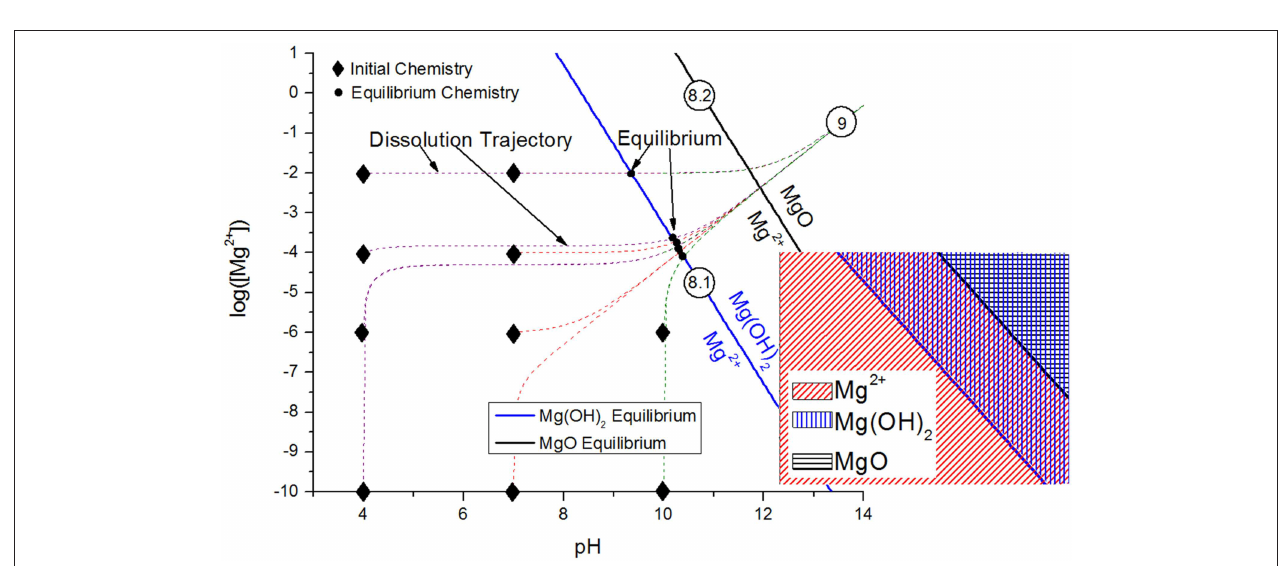
FIGURE 13 | Chemical stability diagrams detailing the ability of these thermodynamic derivations to predict corrosion product stability and conditions for formation in the Mg system (McMahon et al., 2019a). Reproduced with permission.